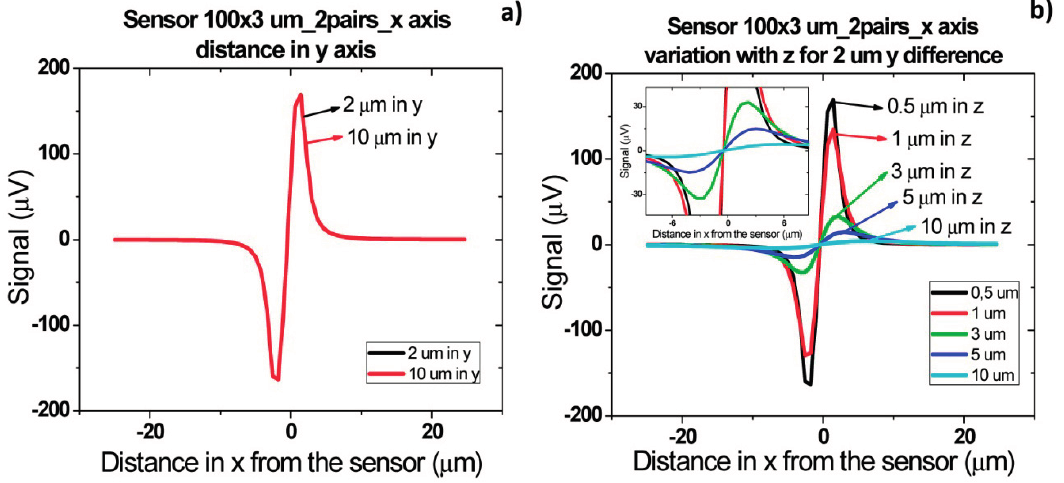
Figure 18. Signal simulation for two Streptococcus agalactiae along y axis. ( a ) Cells at a given distance along y axis; ( b ) Signal variation with height from the sensor for cells at 10 μ m distance from each other along y